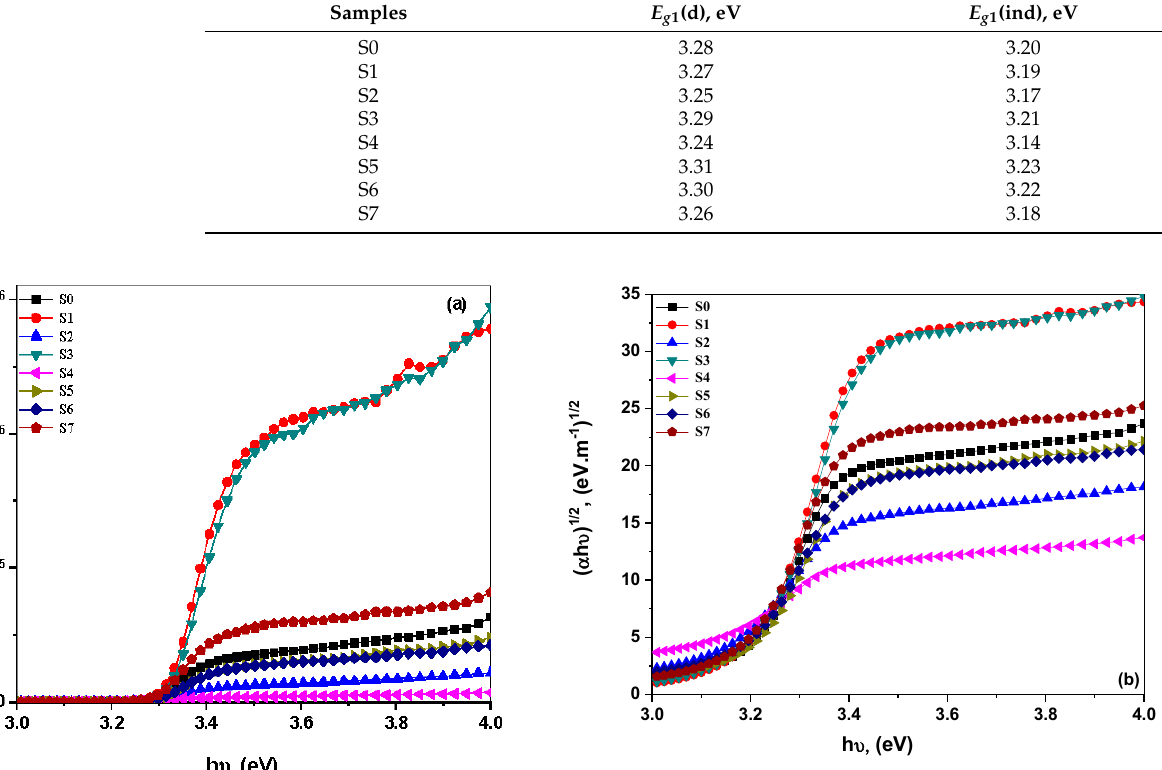
Figure 6. ( a , b ) Illustration of the relation between the optical allowed direct ( α h υ ) 2 and indirect ( α h υ ) 1/2 transitions of the prepared Eu 2 O 3 -doped ZnO nanocomposites versus the photon energy ( h υ